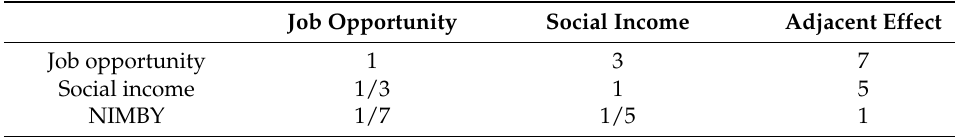
Table 8. Importance scale of the social